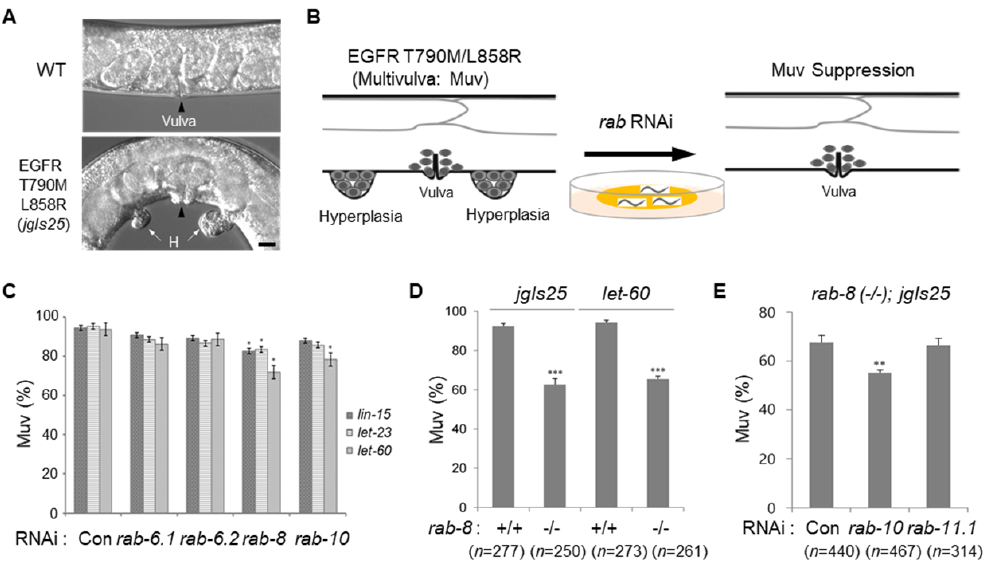
Figure 1. E ff ects of rab RNAi on Muv suppression in C. elegans strains with hyper EGFR activity. ( A ) The epidermal growth factor receptor (EGFR) T790M-L858R expressing strain ( jgIs25 ) exhibits a tumor-like cell mass (H = hyperplasia indicated by white arrows) in addition to the normal vulva (black arrowhead). It is called multivulva (Muv) because hyperplasia arises from vulval precursor cells (VPCs). Scale bar = 10 μ m. ( B ) Screening procedure using 30 rab gene knockdown by feeding RNAi to the jgIs25 strain. ( C ) C. elegans Muv mutant strains ( lin-15 , let-23 , let-60 ) were fed with RNAi for indicated rab s and worms with multivulva were counted under the dissecting microscope. More than 200 adult worms were counted in each group. ( D ) Muv strains, jgIs25 and let-60, were cross with rab-8 (-/-) mutant and worms with multivulva were counted. ( E ) The rab-8 (-/-); jgIs25 strain fed with RNAi for indicated rab s and worms with multivulva were counted. Muv (%) = Percentage of individuals showing multivulva. Error bar = SEM. WT = wild type and Con = control. ( n = number of worms counted). (* p < 0.05, ** p < 0.01, *** p < 0.001 versus Con). These experiments were performed three times with comparable results.